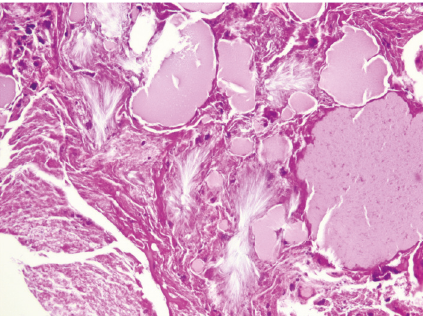
Figure 3: In areas, the material was revealed to have birefringent filamentous areas and a crystalline appearance (H-E 20x).